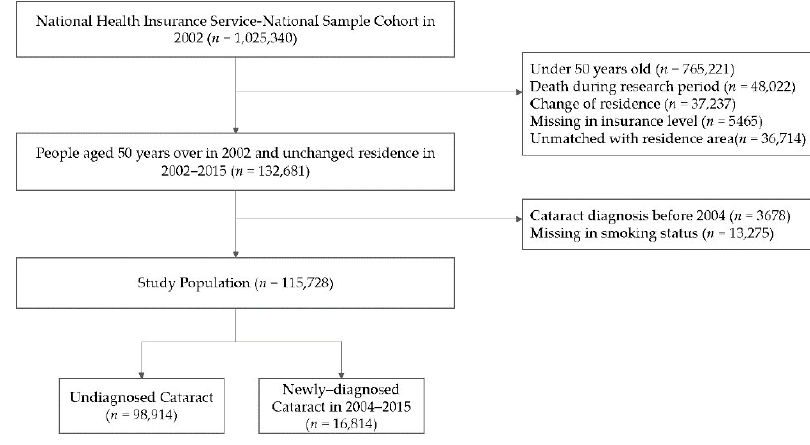
Figure 1. Flow chart of study population.